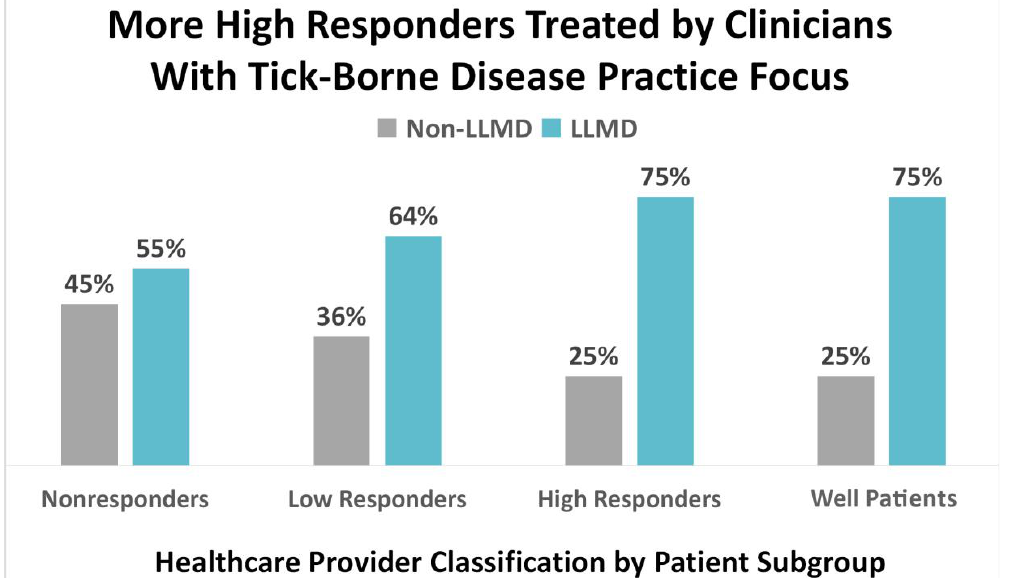
Figure 6. High treatment response is associated with medical oversight by clinicians whose practices focus on tick-borne disease; 75% of high responders and well patients report that their physician was “a Lyme disease specialist or ILADS-a ffi liated Lyme